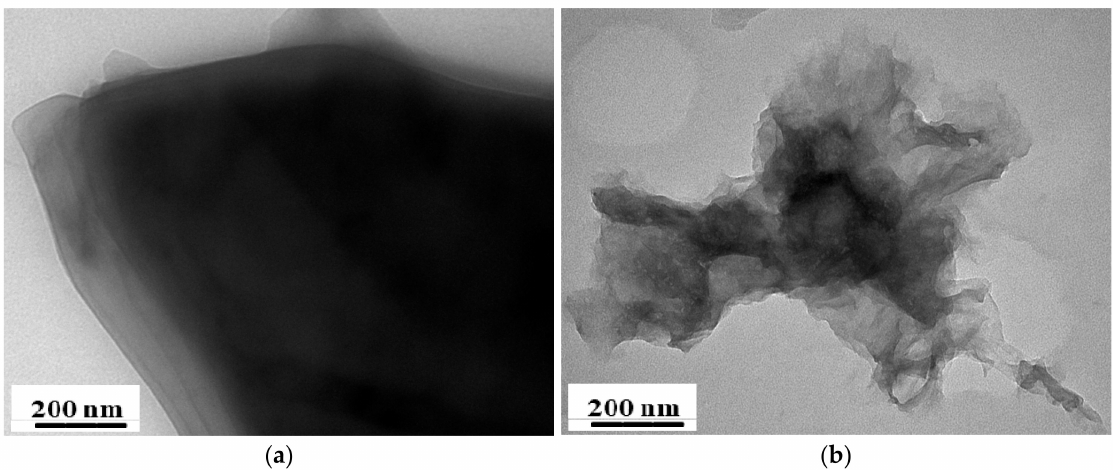
Figure 4. Typical transmission electron microscope (TEM) images of ( a ) graphite, and ( b ) graphene oxide (GO) in a dry state.